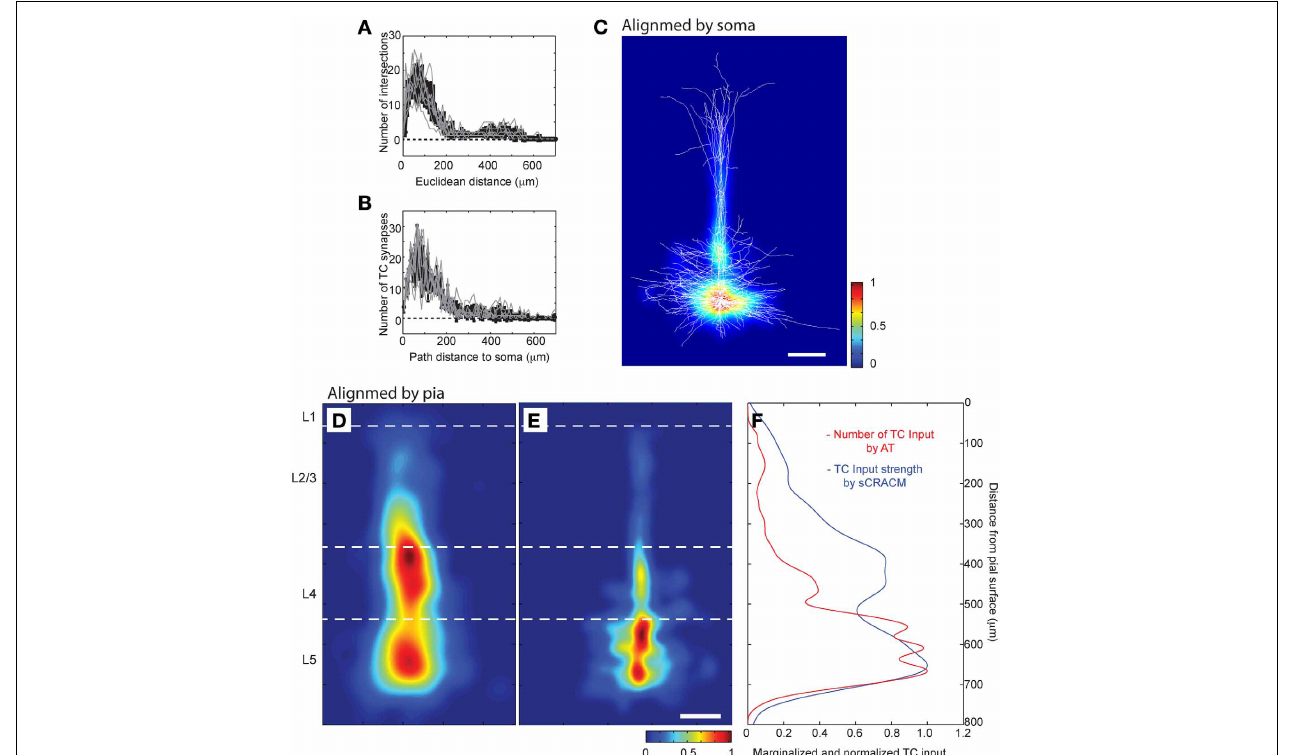
FIGURE 8 | LSAT shows that TC synapses are concentrated on proximal basal dendrites of L5 pyramidal neurons. (A) Three dimensional Scholl analysis of dendritic structure of reconstructed L5 pyramidal neurons, and (B) Number of TC synapses as a function of path distance from center of soma. (C) Average density of TC synapses from all annotated neurons (aligned relative to cell bodies; false color scale) represented on top of all dendrites from all the traced neurons